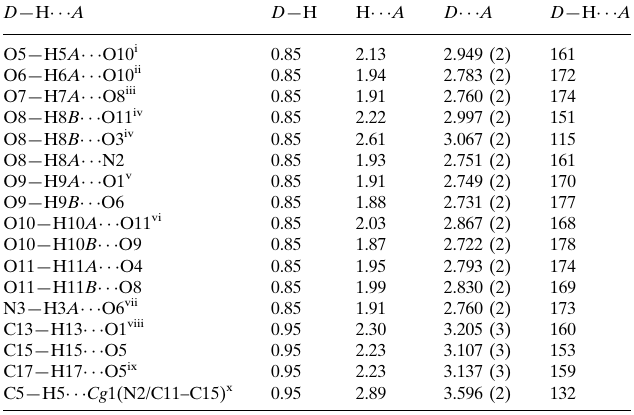
Hydrogen-bond geometry (A˚ , (cid:3) ). D —H (cid:1)(cid:1)(cid:1)